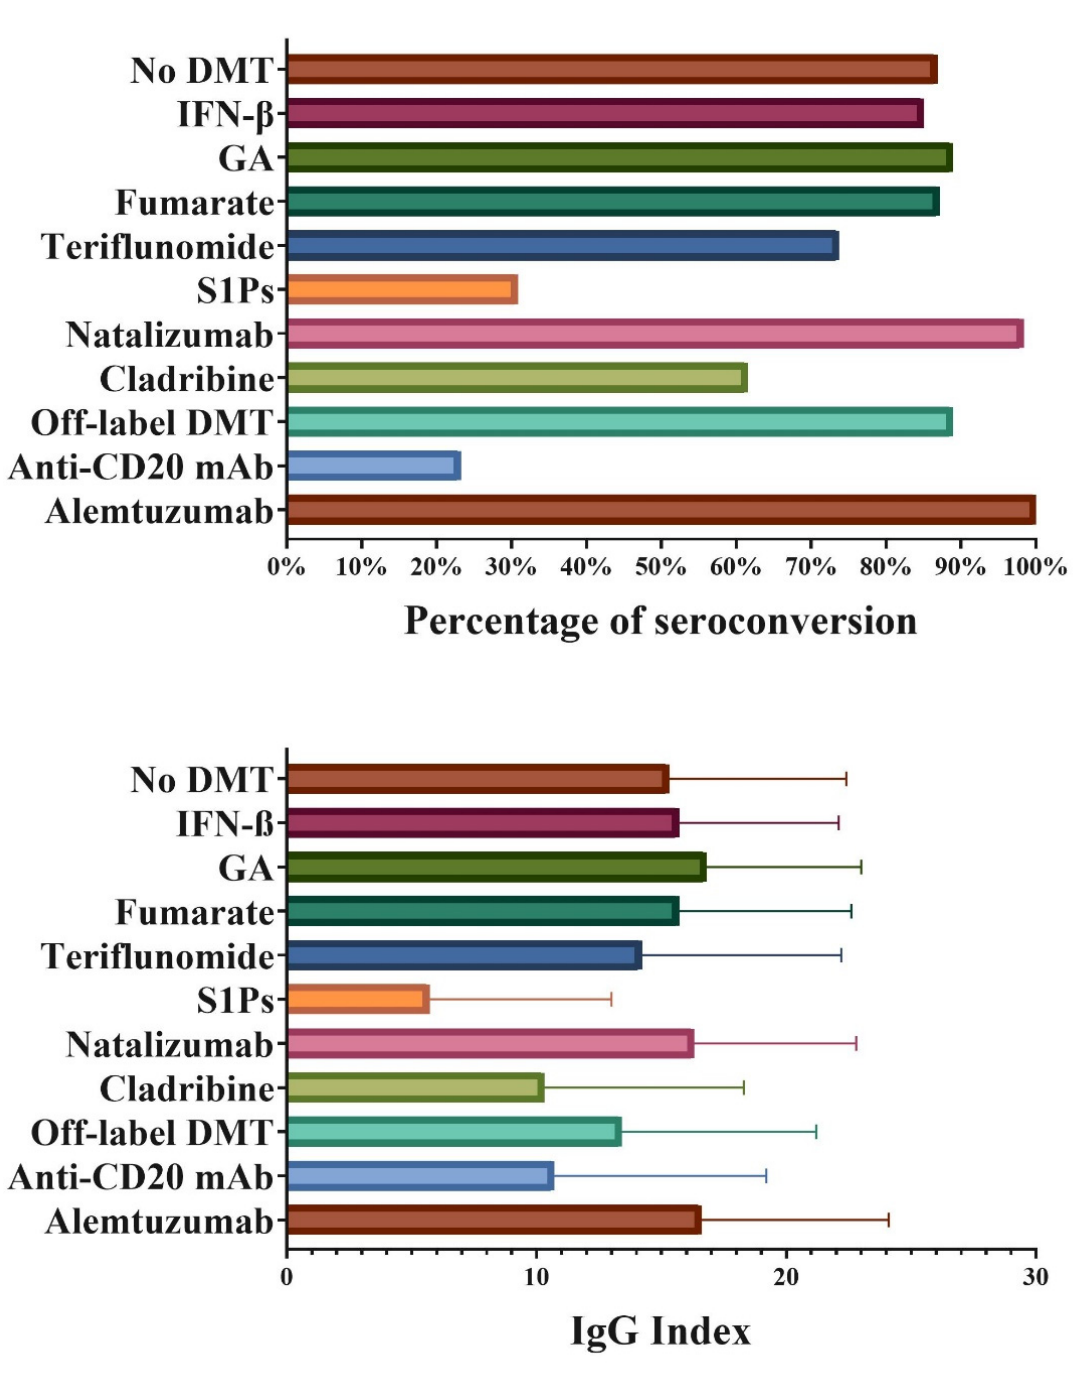
Figure 1. COVID-19 vaccine seroconversion and IgG index in seropositive patients based on disease